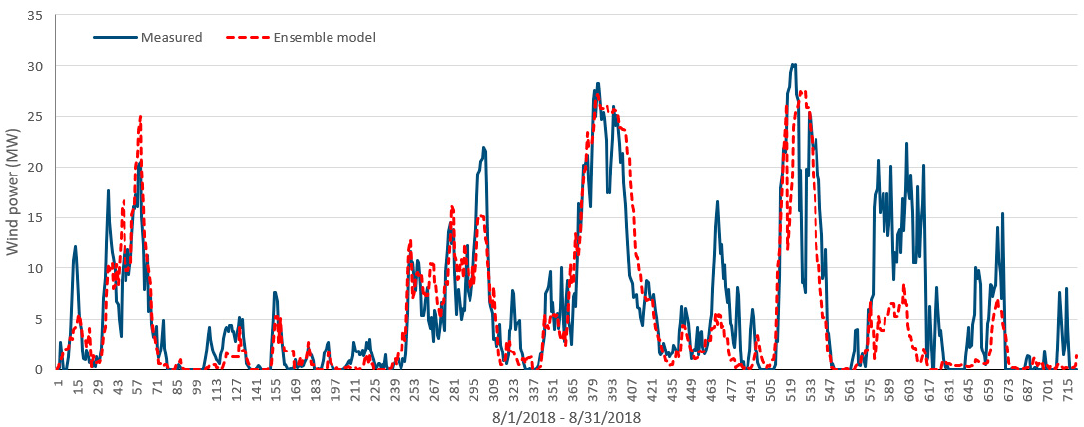
Figure 7. Weights for ensemble model (the x axis represents the 1 day intervals time for the evaluation period). Table 4. Accuracy of wind power forecast.